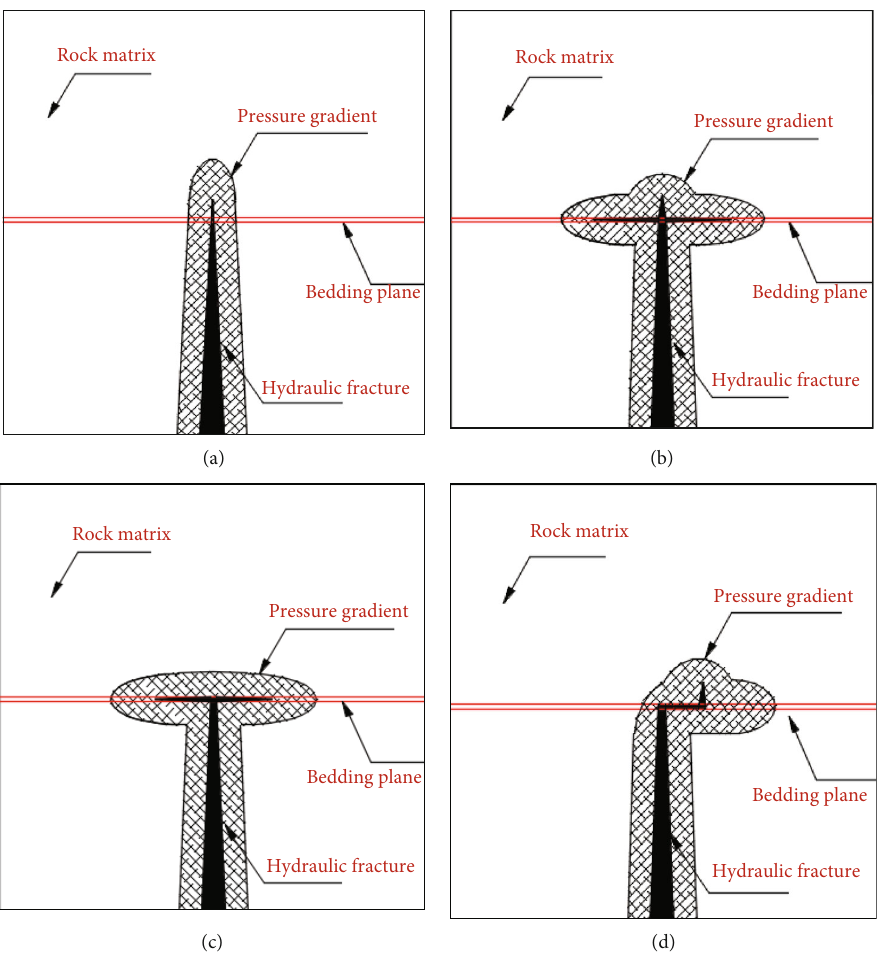
Figure 18: Mode of hydraulic fracture extension at bedding